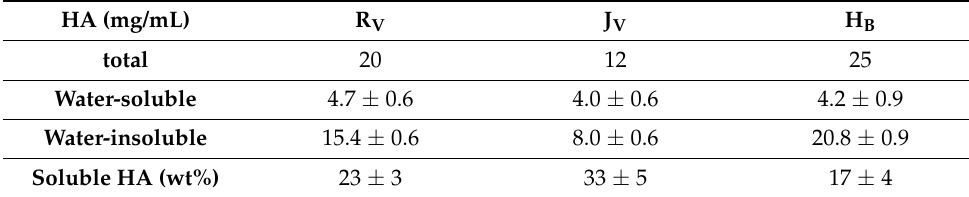
Table 1. Amount of water-soluble and